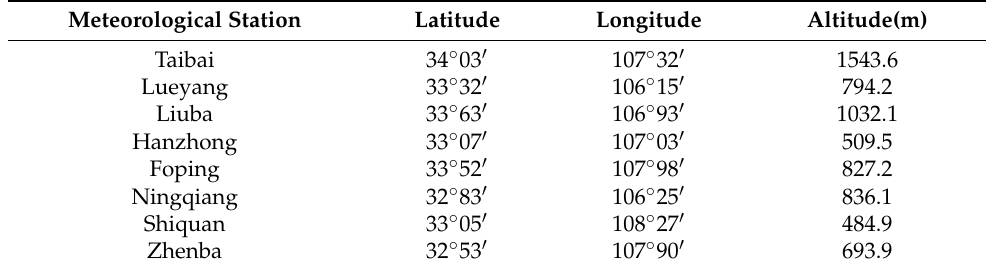
Table 1. Meteorological station information in the study